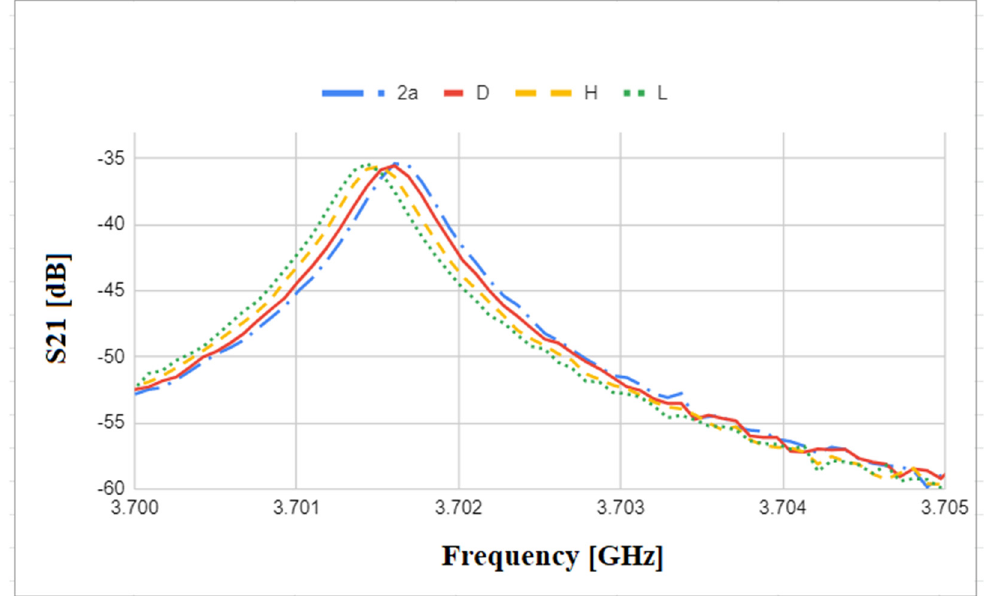
Energies 2021 , 14 , x FOR PEER REVIEW Figure 19. Location of the peaks of the master diamonds at 3.7 GHz. Figure 19. Location of the peaks of the master diamonds at 3.7 GHz.